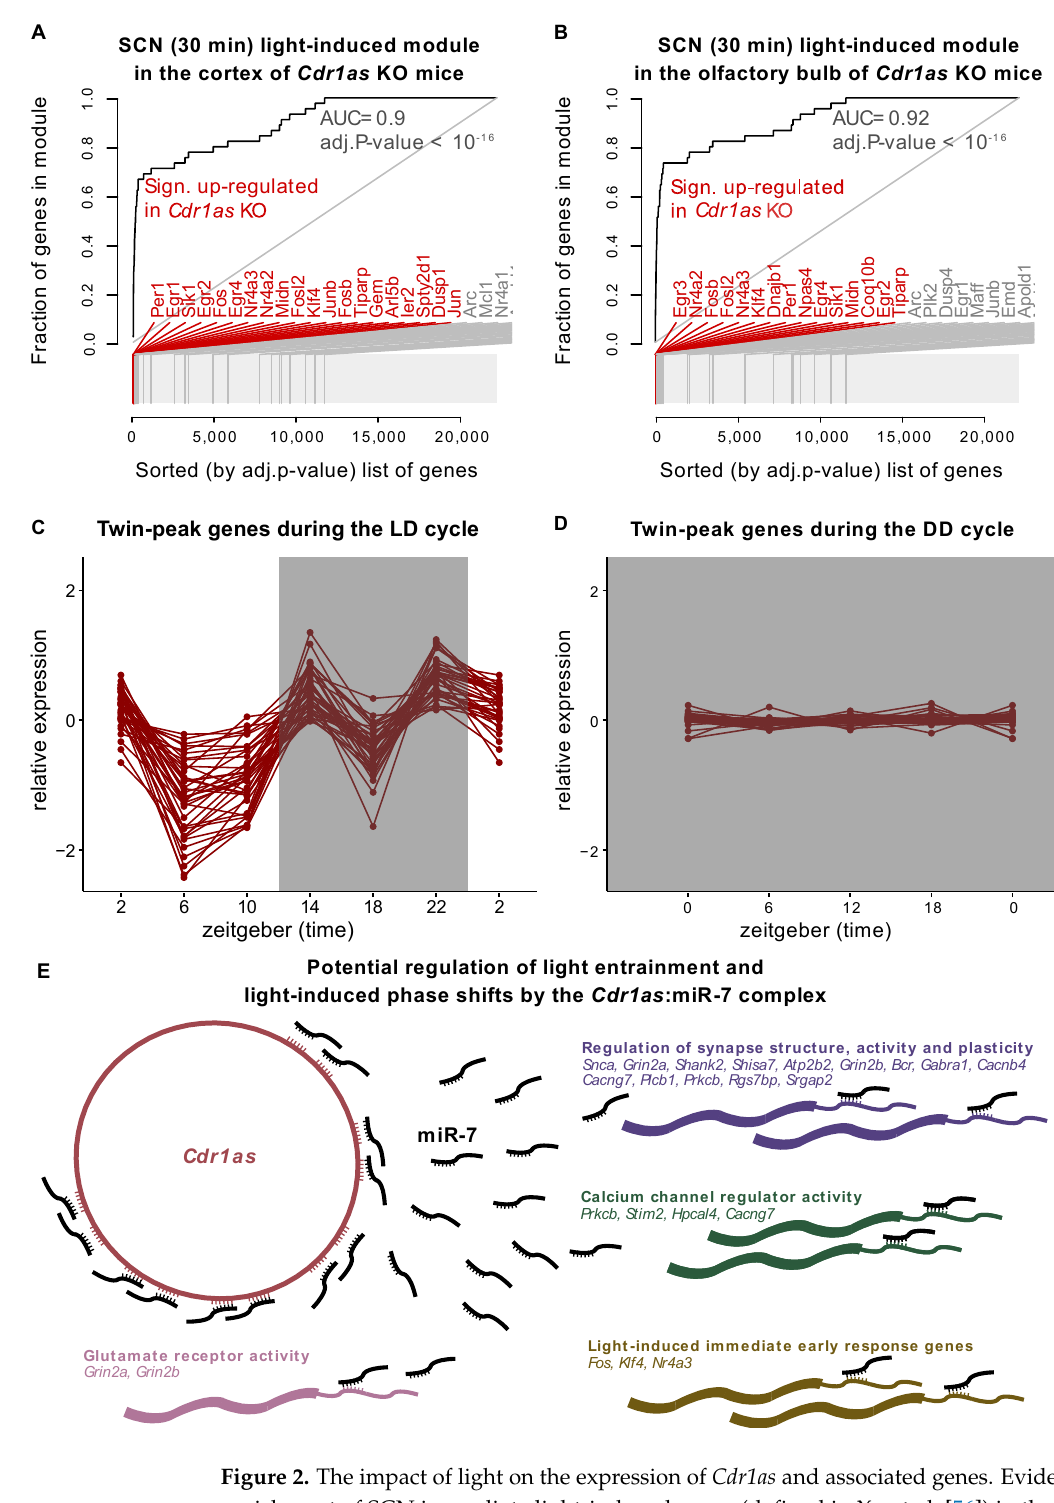
Figure 2. The impact of light on the expression of Cdr1as and associated genes. Evidence plots show enrichment of SCN immediate light-induced genes (defined in Xu et al. [56]) in the ( A ) cortex and ( B ) olfactory bulb of Cdr1as KO mice. The X-axis shows the list of sorted genes (by adj. p -value Cdr1as KO vs. WT) from polyA RNA-Seq in Piwecka et al. [31]. Y-axis is the fraction of the gene set defined by Xu et al., 2021 [56]. In red are genes upregulated in Cdr1as KO with adj. p -value < 0.05. ( C ) Log2 expression (normalized to the temporal mean) of the top 50 genes (sorted by FPKM) from the twin-peak module in the LD cycle [7]. ( D ) The same set of genes (as in C) in the DD cycle. Cheng et al. [57] measured RNA expression in control and Sox2 mutant mice in the DD cycle at four different time points. Here, we used only control samples. ( E ) Cdr1as and miR-7 are both expressed in the SCN. Predicted targets of miR-7 were downloaded from Targetscan [60]. Twin-peak genes